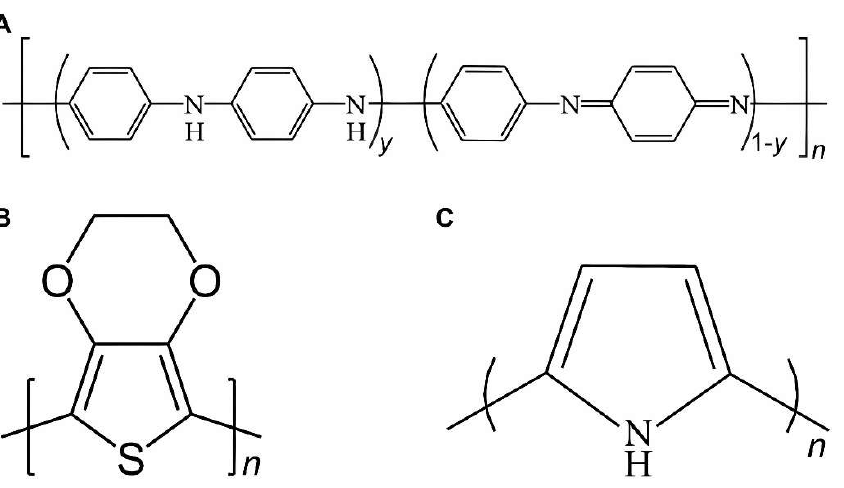
Figure 2. New generation of conductive polymers (CPs). ( A ) polyaniline (PANi); ( B ) poly(3,4-ethylenedioxythiophene) (PEDOT); ( C ) polypyrrole (PPy).